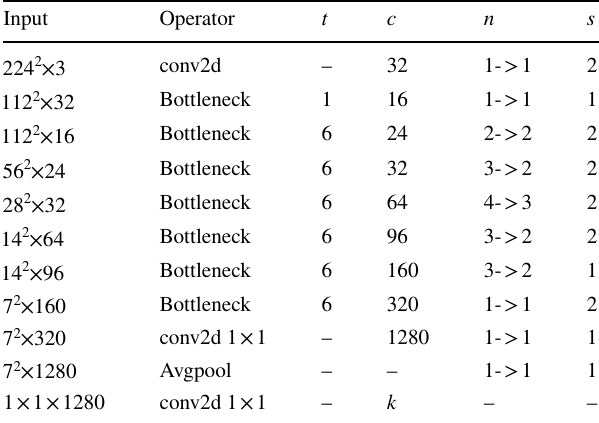
Table 1 In this table, the t expresses the multiple of 1 × 1 convolution to raise dimensions, the c means the number of channels about 1 × 1 convolution, the n show times of bottleneck from MobileNet V2 to ECMobileNet, and the s is the